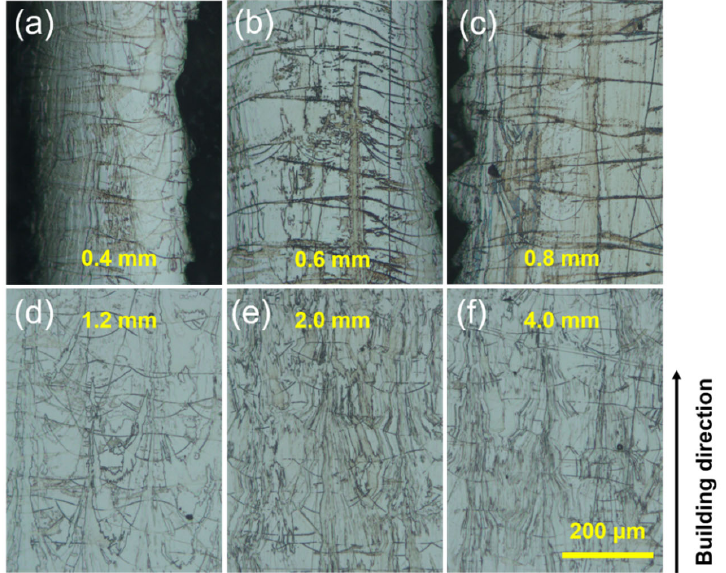
Figure 4. Optical micrographs of thin-wall structures along the build direction with different thickness under scanning speed of 800 mm/s: ( a ) 0.4 mm, ( b ) 0.6 mm, ( c ) 0.8 mm, ( d ) 1.2 mm, ( e ) 2.0 mm, and ( f ) 4.0 mm.